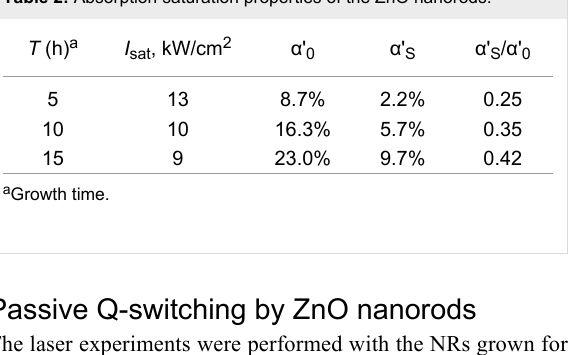
Table 2: Absorption saturation properties of the ZnO